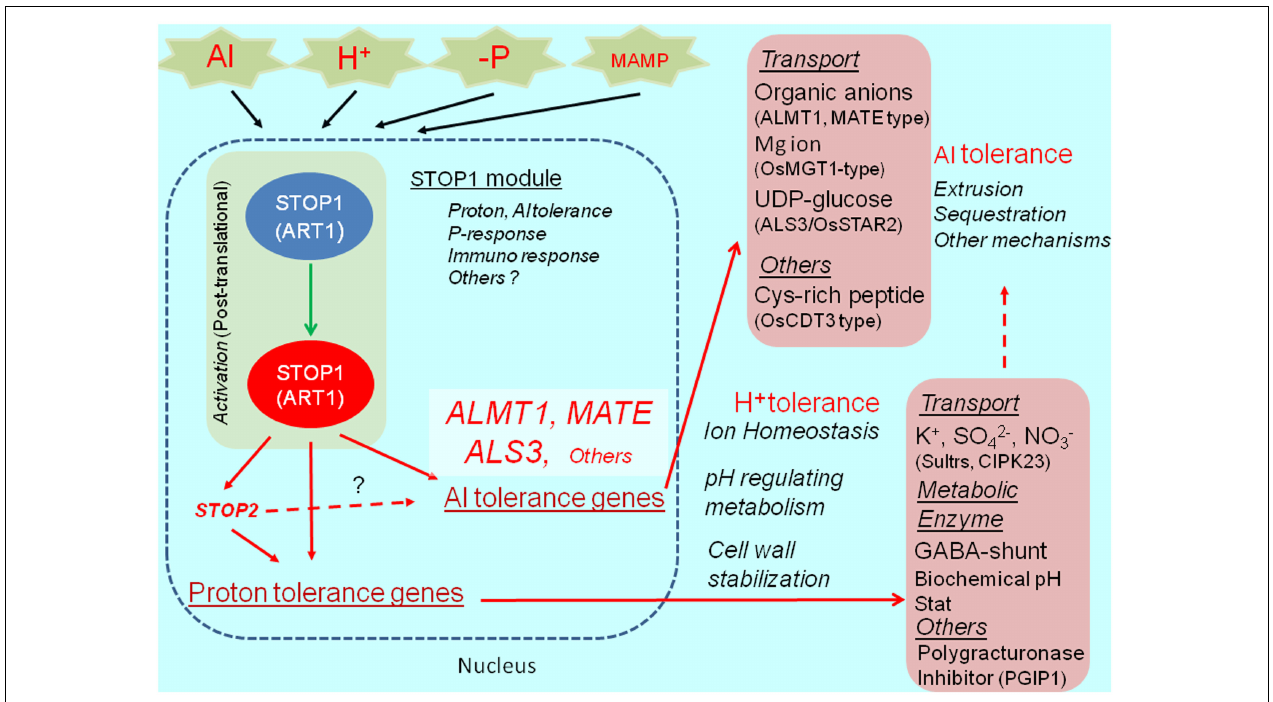
FIGURE 2 | STOP1 module and ALMT1 regulation. The SENSITIVE TO PROTON RHIZOTOXICITY1 (STOP1) module, which is consisted of STOP1-like protein (in Arabidopsis, STOP1; in rice ALUMINUM RESISTANCE TRANSCRIPTION FACTOR 1), OA transporters ALUMINUM ACTIVATED MALATE TRANSPORTER1 ( ALMT1 ), malate transporter; MULTIDRUG AND TOXIC COMPOUNDS EXTRUSION ( MATE ); citrate transporter, and ALUMINUM SENSITIVE 3 ( ALS3 ), are conserved in wide range of plant species. The module includes various Al tolerance genes and possibly H + tolerance genes (pink box), which play critical role in Al detoxification, ion homeostasis (transport and metabolisms), cell wall stabilization and other roles for tolerance. In Arabidopsis, STOP1 regulates STOP2 expression, while STOP2 only regulates expression of H + tolerance genes. STOP1-regulating gene, such as ALMT1, is activated by various environmental stimuli (Al, H + -P and MAMP, Microbe Associated Molecular